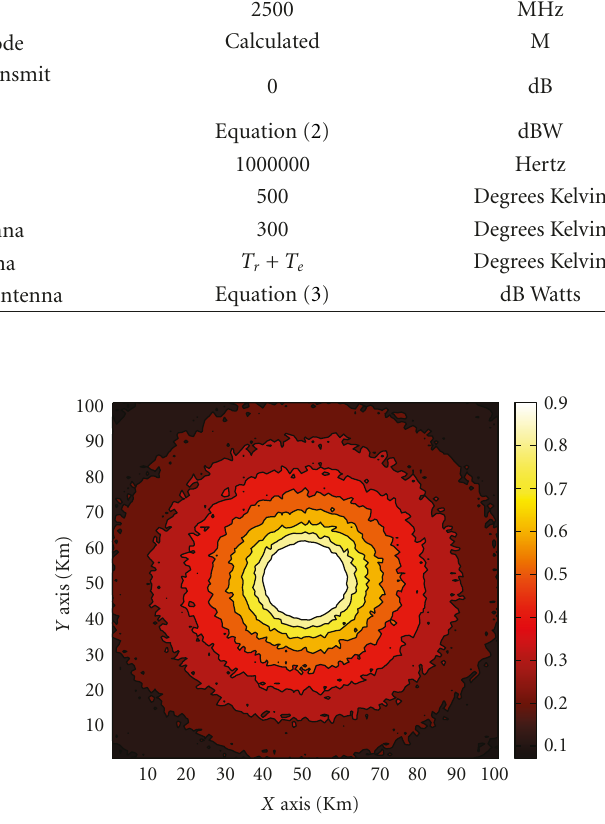
Figure 5: An omnidirectional antenna’s detection probability map.